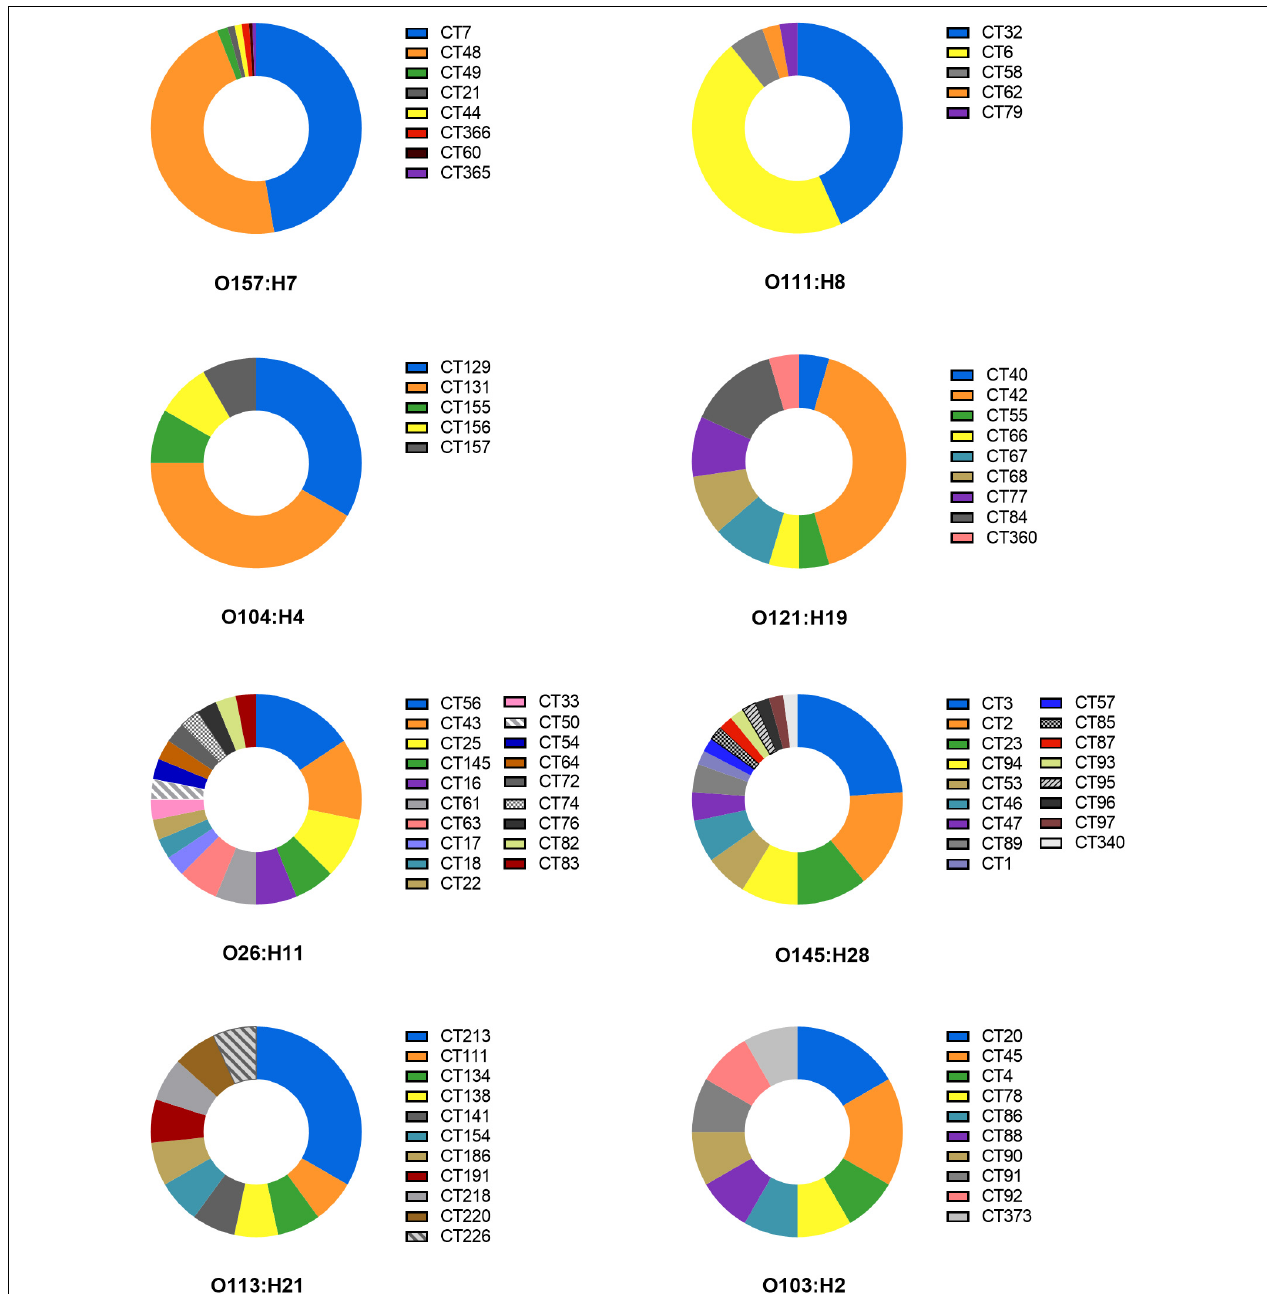
FIGURE 2 | CRISPR typing distribution of the same serotype